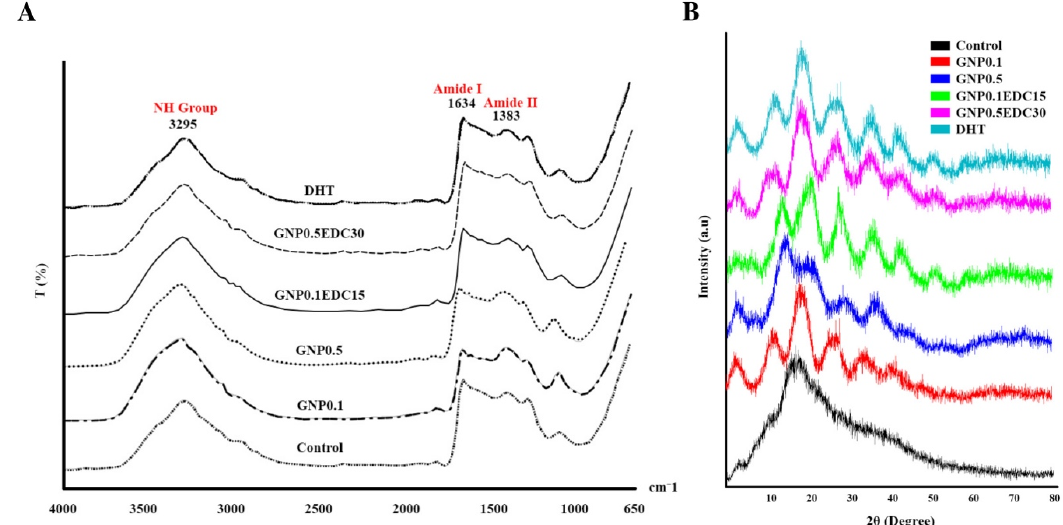
Figure 4. Effect of crosslinking on chemical composition and structure. ( A ) FTIR peaks indicate the chemical functional group detected in GS. Crosslinking did not alter the chemical functional group composition of gelatin. ( B ) XRD diffractogram indicates the crystal structure of GS. Crosslinking did not alter the crystal structure of gelatin.